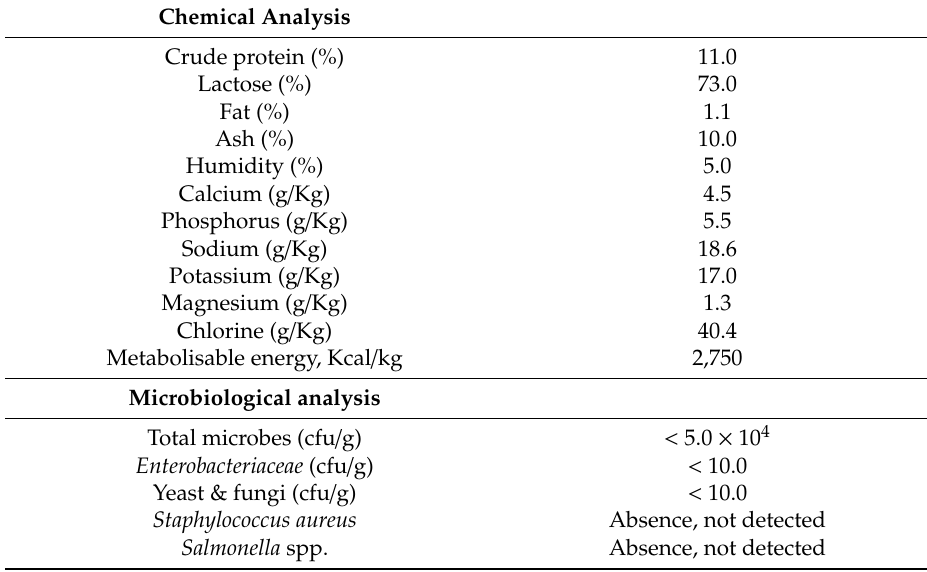
Table 2. Chemical and microbiological analysis of commercial whey powder